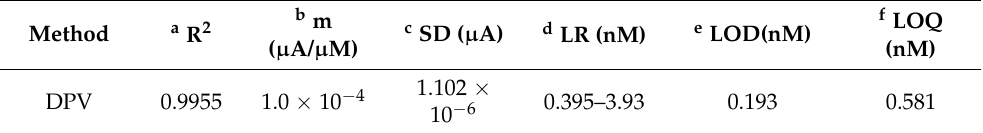
Table 1. Figures of merit of DA detection by the DPV